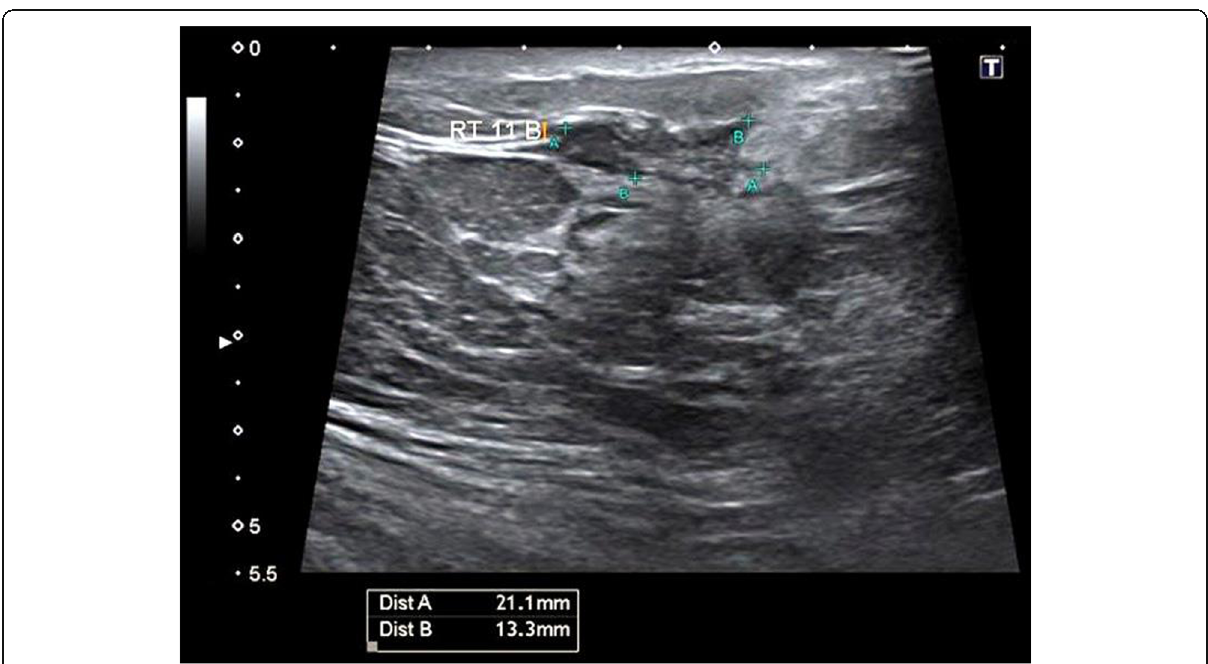
Fig. 1 B-mode US showed an irregular hypoechoic speculated solid mass with posterior shadowing measuring about 27 × 18 mm, assessed as BIRADS 5. Pathology: true cut biopsy revealed invasive ductal carcinoma grade II. Biological markers: ER positive, PR positive, HER/neu-2 negative, and Ki67